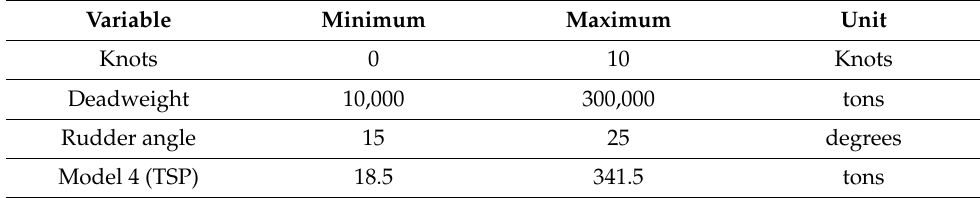
Table 5. Validity range of Model